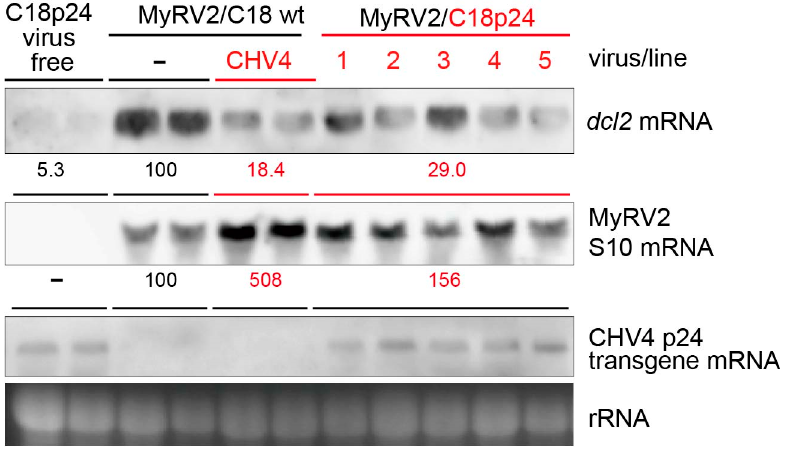
Figure 4. Suppression of transcriptional upregulation of dcl2 by CHV4-C18 p24. Total RNA fractions were obtained from fungal strains shown on the top. C. parasitica C18 non-transformants infected by MyRV2 (C18/MyRV2), and MyRV2 plus CHV4 (C18/MyRV2+CHV4), CHV4 p24 transformants uninfected (C18p24-VF) or infected by MyRV2 (C18p24/MyRV2). Four independent transformants (1 to 5) were tested in this experiment. Total RNA was examined by northern blotting for dcl2 transcripts, MyRV2 S10 mRNA, and CHV4-C18 p24 transgene transcripts. Ribosome RNA (rRNA) serves as a loading control. Mean values of band intensity in the northern blots quantified by ImageJ are shown below each blot. Note that the presence of CHV4 genomic RNA was confirmed in fungal strain C18 doubly infected MyRV2 and CHV4.